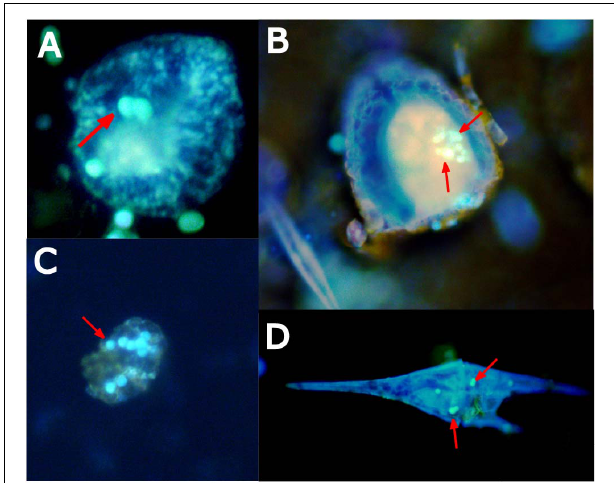
FIGURE 6 | Epifluorescence microscopy images of coastal marine microplankton, such as ciliates (A,B) , dinoflagellates (C) , and Ceratium (D) , stained with primuline dye with confirmed microplastic ingestion (fluorescent spheres denoted by red arrows) after 24-h of